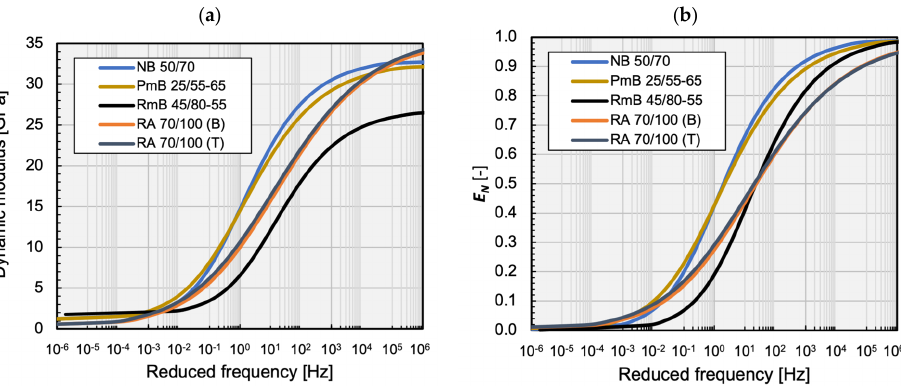
Figure 5. RAMBO master curves of the dynamic modulus ( a ) and the normalised dynamic modulus ( b ) depending on the reduced frequency. Specimens mixed with reclaimed asphalt for the bottom RA 70/100 (B) and top RA